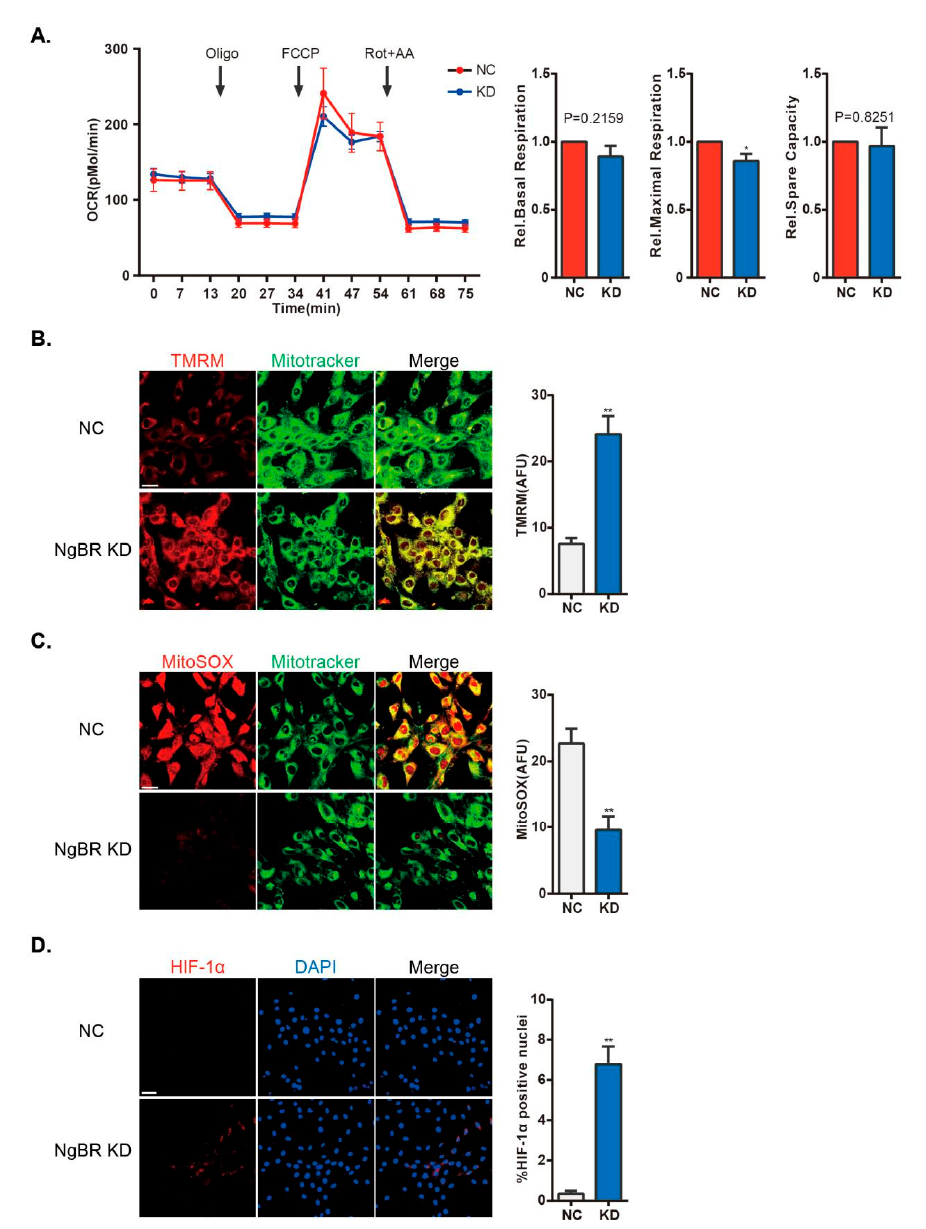
Figure 5. Downregulation of NgBR compromises mitochondrial function in normoxic VSMCs. ( A ) Representative line and bar graphs of OCR of NS and NgBR KD cells. n = 20–21 wells from four individual experiments. mROS generation and ∆Ψ were assessed by ( B ) TMRM fluorescent probes (n = 13–14 pictures / group) and ( C ) MitoSOX ™ Red (n = 13–16 pictures / group). Results were calculated as AFU using ImageJ. Scale bar = 20 µ m. ( D ) Representative confocal microscopy images showing staining of HIF-1 α (red) and DAPI (nuclear stain; blue). Percentage of HIF-1 α -positive nuclei was calculated using FV10-ASW3.1 software. n > 30 pictures / group. Scale bar = 40 µ m. * p < 0.05, ** p <